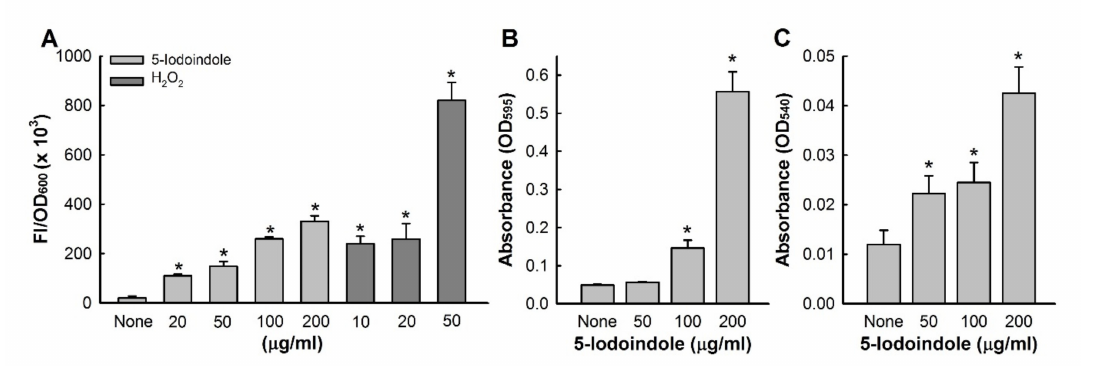
Figure 6. 5-Iodoindole induced ROS production in and membrane release by A. baumannii . ( A ) Intracellular ROS production in A. baumannii cells treated with 5-iodoindole or H 2 O 2 ; Comparative quantitative display of release of ( B ) proteins; ( C ) sugars after 3 h of treatment with 5-iodoindole. Error bars represent standard deviation. * p < 0.05 versus untreated